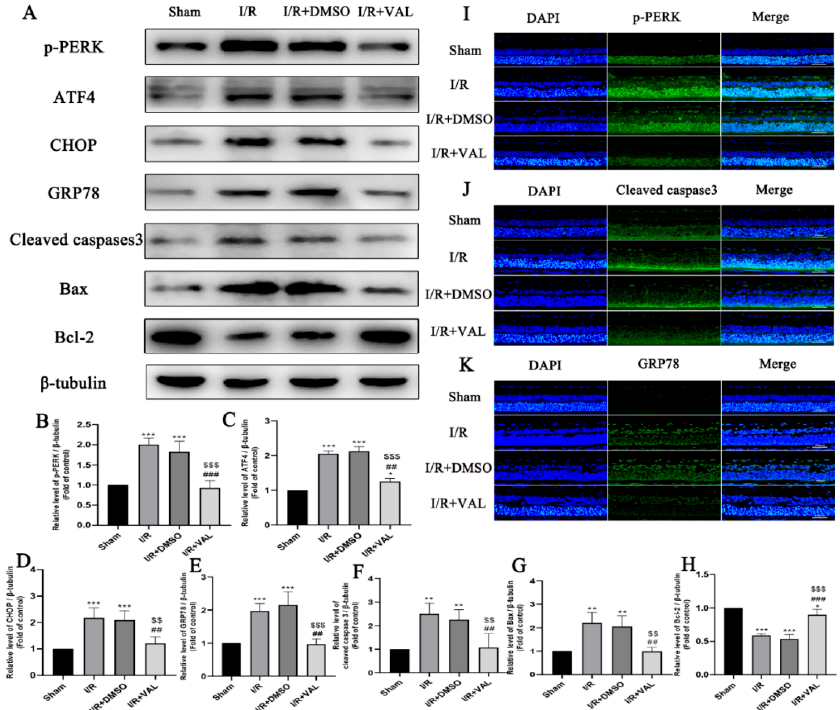
Figure 4. Effect of valdecoxib on the expression of ER stress-related and apoptosis-related proteins in the retinal ischemia-reperfusion model. ( A ) Western blot analysis of p-PERK, ATF4, GRP78, CHOP, cleaved caspase 3, bax and bcl-2 levels in the control, I/R, I/R+DMSO and I/R+VAL groups. β -tubulin served as the loading control. ( B – H ) Quantification of expression levels of p-PERK, ATF4, GRP78, CHOP, cleaved caspase 3, bax and bcl-2 in the control, I/R, I/R+DMSO and I/R+VAL groups using the densitometric analyses of Western blotting. The bar charts show the quantitative data (normalized by β -tubulin) for each protein relative to the sham group (assigned a value of 1). ( I ) Representative fluorescence images of p-PERK staining are shown (scale bar = 50 µ m). Immunostaining was executed using a primary antibody against p-PERK (green), and the nucleus (blue) is marked by DAPI. ( J ) Representative fluorescence images of cleaved caspase 3 staining are shown (scale bar = 50 µ m). Immunostaining was executed using a primary antibody against cleaved caspase 3 (green), and the nucleus (blue) is marked by DAPI. ( K ) Representative fluorescence images of GRP78 staining are shown (scale bar = 50 µ m). Immunostaining was executed using a primary antibody against GRP78 (green), and the nucleus (blue) is marked by DAPI. Images demonstrate the increased expression level of p-PERK, cleaved caspase 3 and GRP78 in the I/R and I/R+DMSO groups, and decreased expression level of those proteins in the I/R+VAL group in the retinal ganglion cell layer. Data are represented as the mean ± SD of three independent experiments. Each group was composed of five rats. One-way ANOVA is used in B to H. * p < 0.05, ** p < 0.01, *** p < 0.001 vs. sham group. ## p < 0.01, ### p < 0.001 vs. I/R group. $$ p < 0.01, $$$ p < 0.001 vs. I/R+DMSO